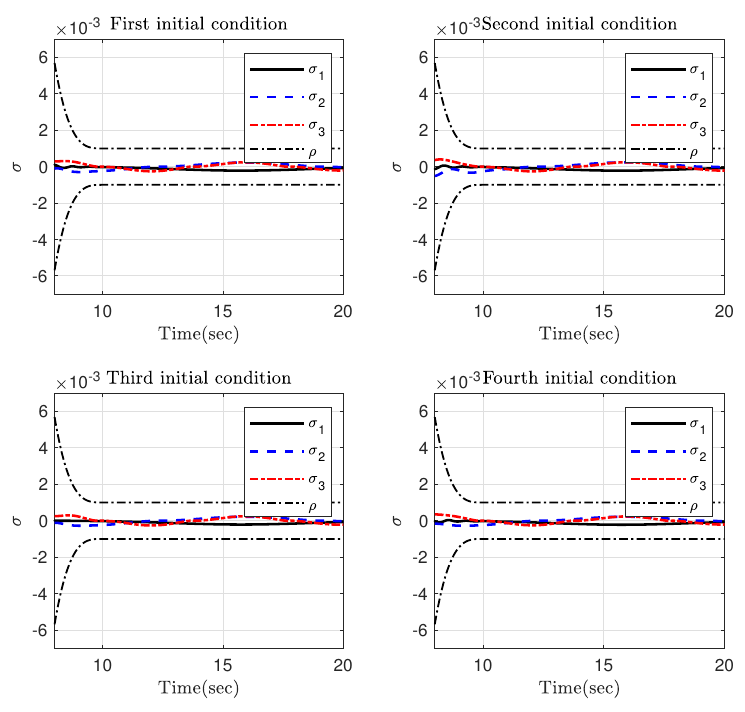
Figure 5. Steady state behavior of the attitude in Part 1 for different initial